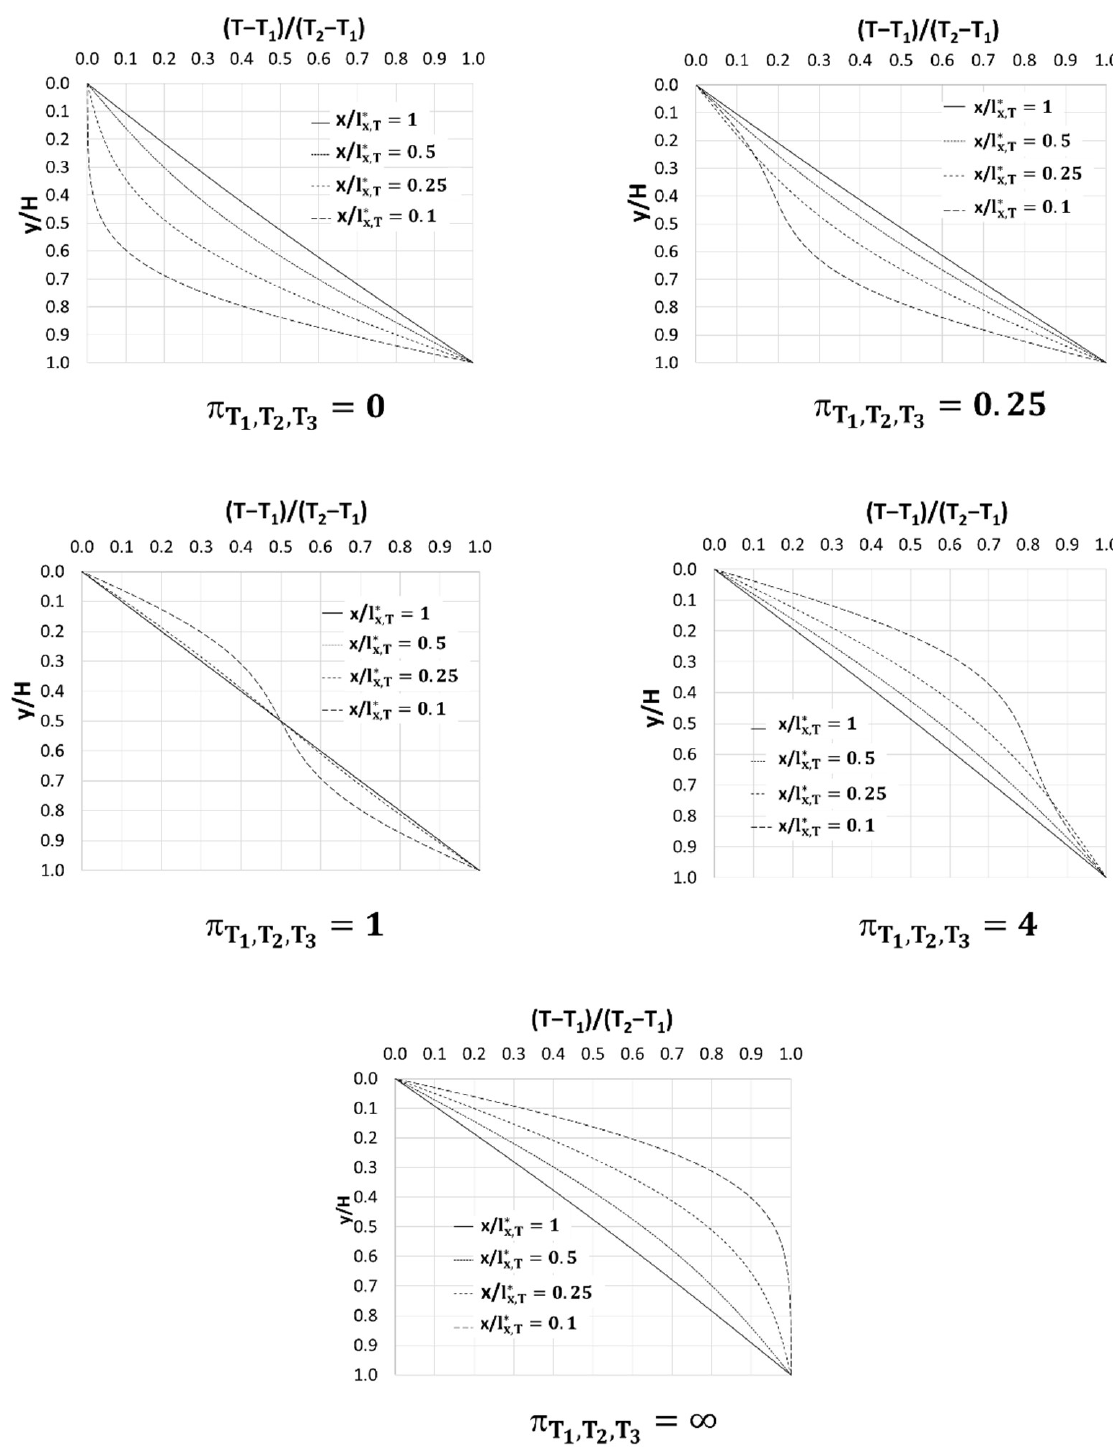
= 0,  = Figure 9. Universal vertical temperature–depth profiles (Expression (24)) for  (cid:2904) = (cid:2904) (cid:3117) ,(cid:2904) (cid:3118) ,(cid:2904) (cid:3119) Figure 9. Universal vertical temperature–depth profiles (Expression (24)) for π T (cid:3117) ,(cid:2904) (cid:3118) ,(cid:2904) (cid:3119) 1 , T 2 ,T 3 0.25 ,  = 1 ,  = 4 and  =  . = 0.25, π = 1, π = 4 and π = ∞ 0, π T (cid:2904) (cid:3117) ,(cid:2904) (cid:3118) ,(cid:2904) (cid:3119) (cid:2904) (cid:3117) ,(cid:2904) (cid:3118) ,(cid:2904) (cid:3119) (cid:2904) (cid:3117) ,(cid:2904) (cid:3118) ,(cid:2904) (cid:3119) T 1 , T 2 ,T 3 T 1 , T 2 ,T 3 T 1 , T 2 ,T 3 1 , T 2 ,T 3